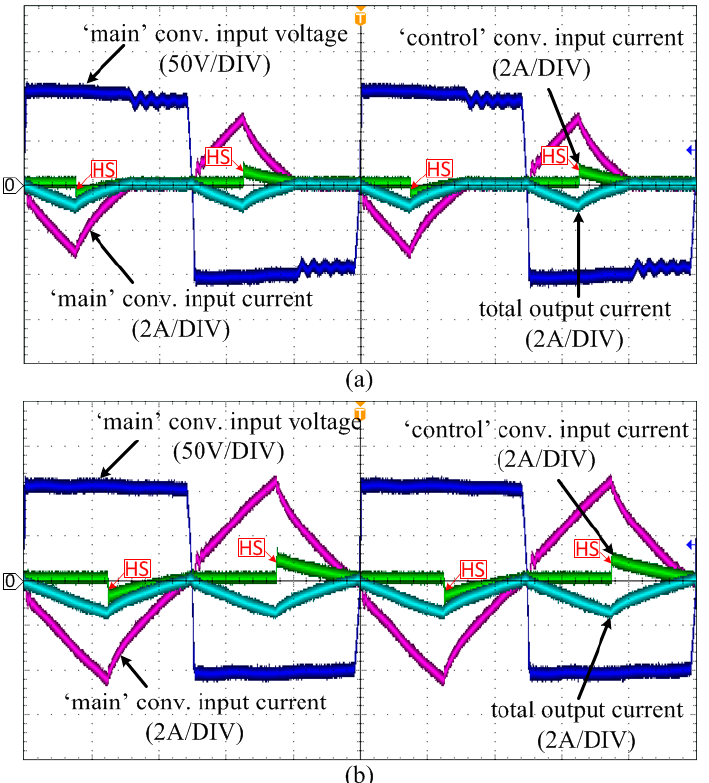
Figure 14. Voltage and current waveforms in the transformers when the BiDUP converter operates in the backward mode with the ‘control’ converter duty-ratios of ( a ) − 0.15 and ( b ) − 0.25, respectively.